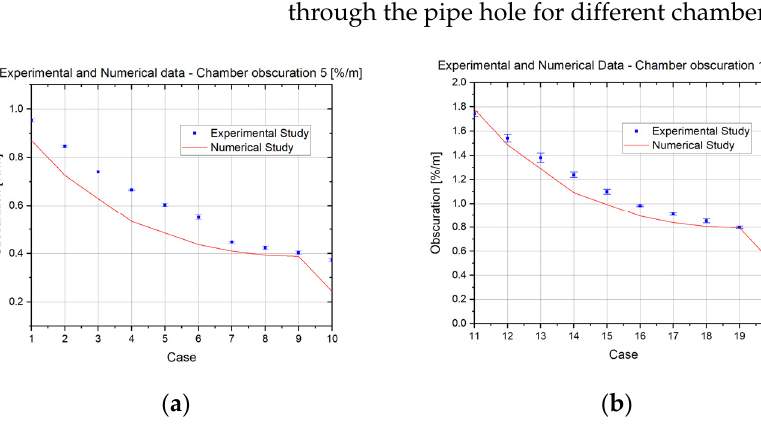
Figure 6. The comparison of obscuration between the numerical and experimental studies ( a ) When the chamber obscuration is 5%/m ( b ) When the chamber obscuration is 10% ( c ) When chamber obscuration is 15%/m.